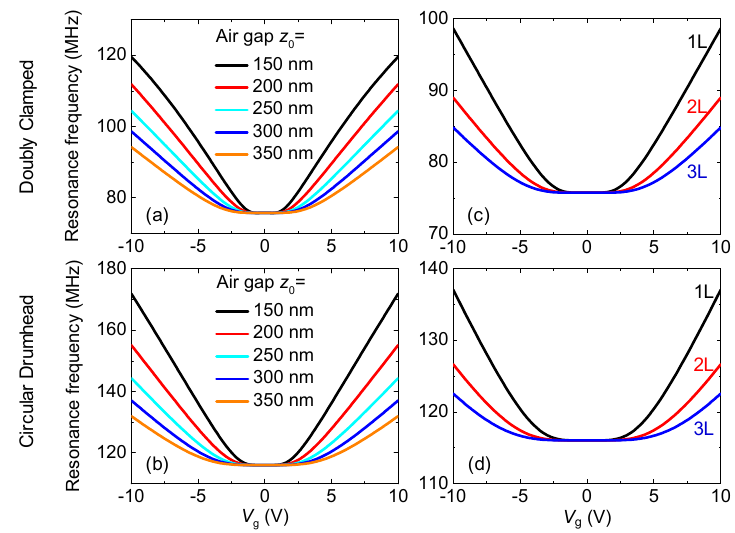
Figure 4. Dependence of resonance characteristics on depth of air gap and number of layers. Frequency tuning of doubly clamped graphene resonators with varying ( a ) air gap and ( c ) number of layers. Simulated resonance frequencies and tuning characteristics for circular drumhead resonators with ( b ) different depth of air gap and ( d ) number of layers.